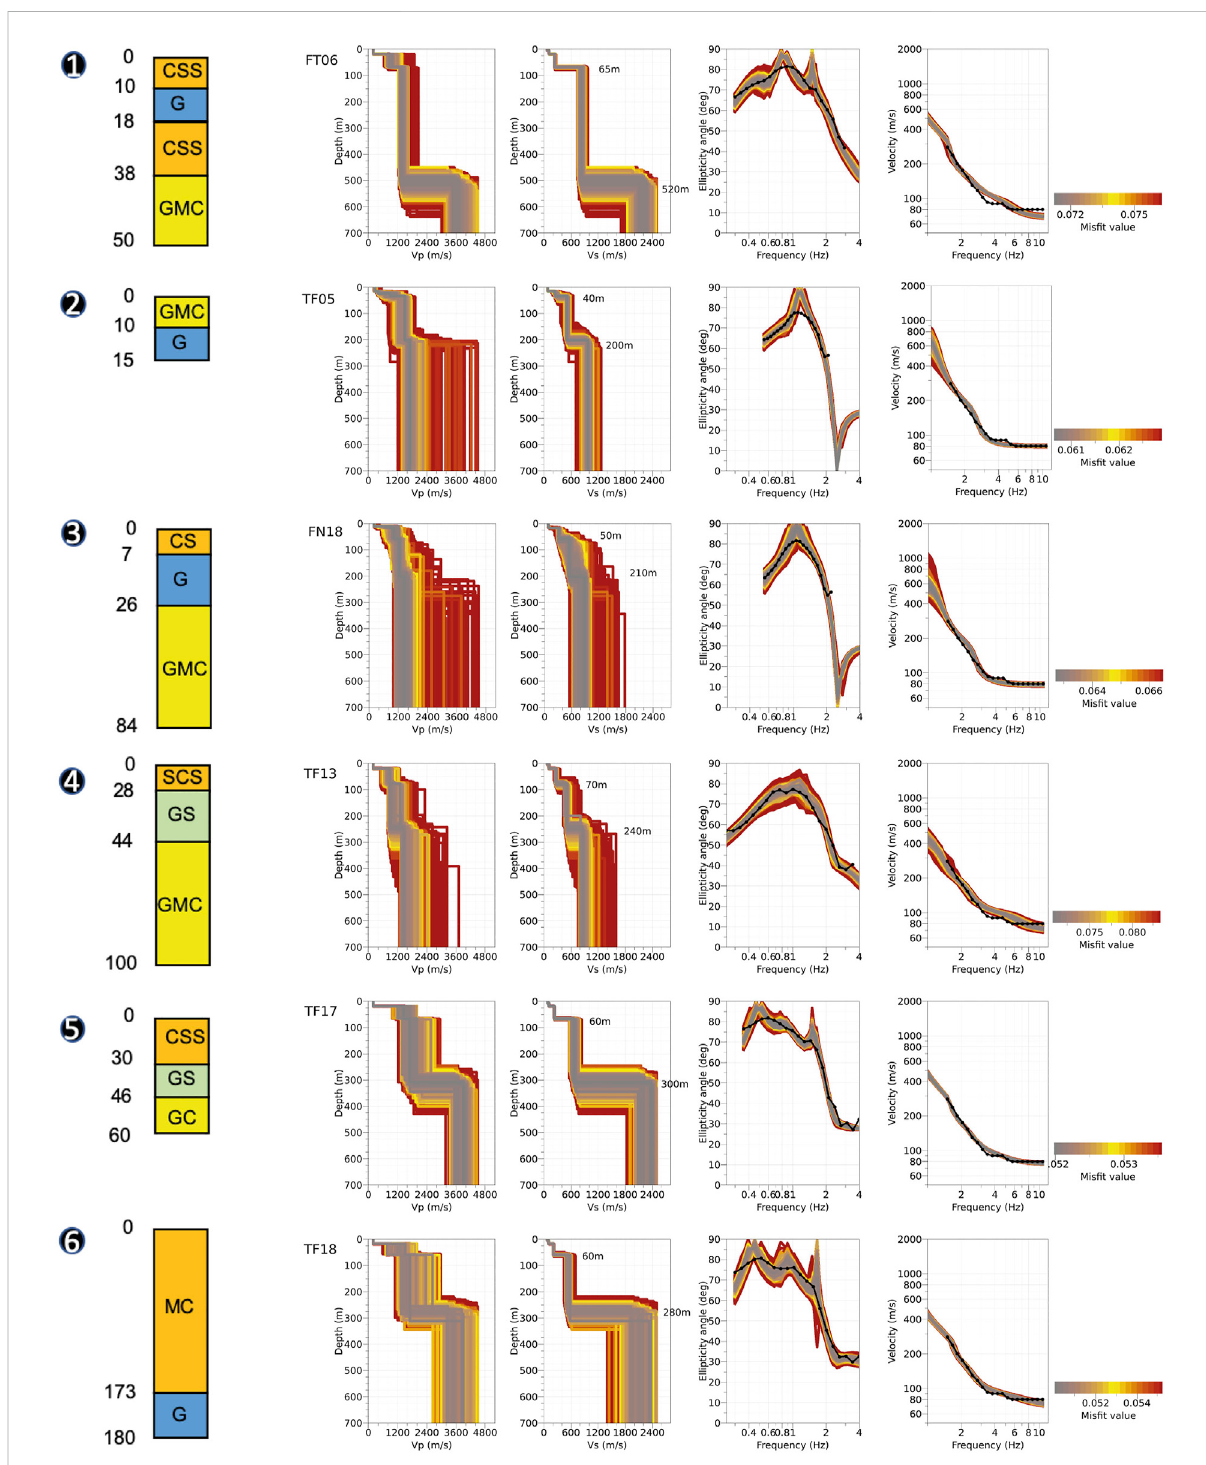
FIGURE 9 1D models (Vp and Vs on the left) for six representative sites selected in the study area (see location in Figure 4). The target curves of the joint inversion (HVNSR considered Rayleigh-wave ellipticity and dispersion curves) are shown in black. The color scale is proportional to the mis fi t betweenexperimentalandtheoreticalcurves.Ontheleft,theboreholelogsavailableareusedtosettheshallowpartoftheinitialsubsoilstructurefor 1D models. Legend of borehole logs: C, MC, and GMC — clay deposits; CSS, SCS, and CS — sand deposits; GS and G — gravel